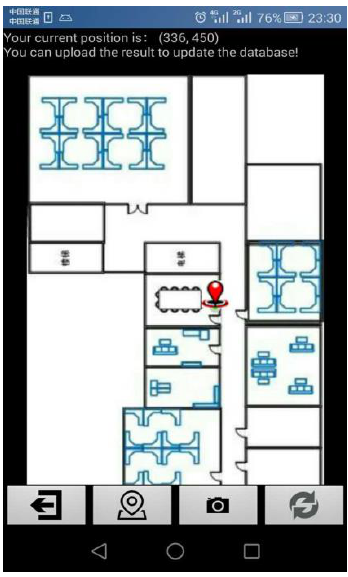
Figure 8. Display interface and positioning result.